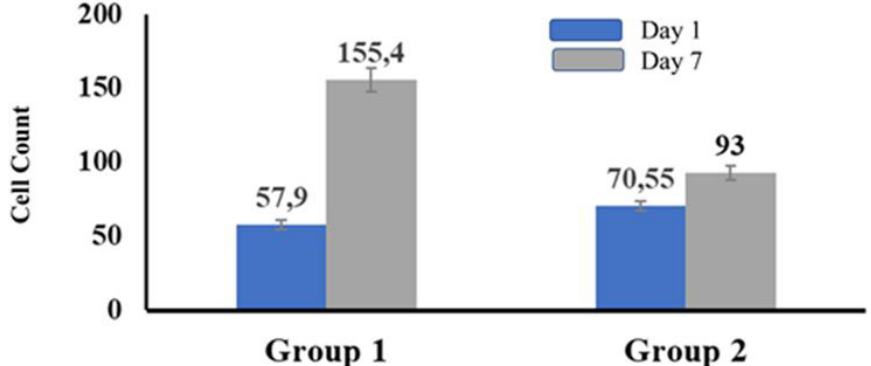
covered with PCL after 1 2